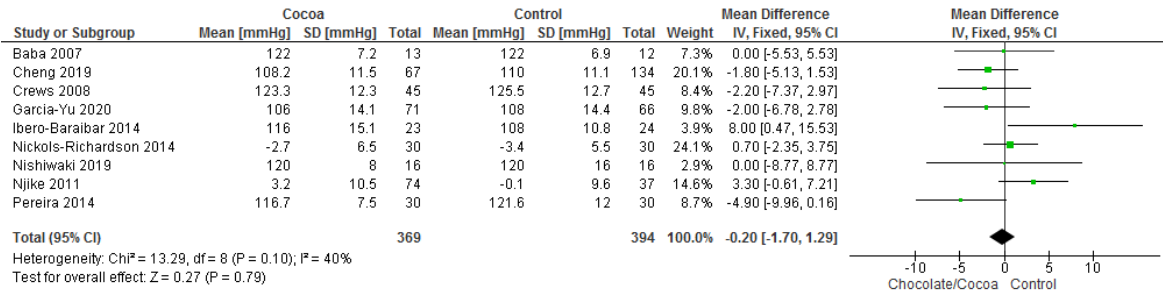
Figure 3. Forest plot of comparison: chocolate versus control, with the outcome-systolic blood pressure (mmHg).